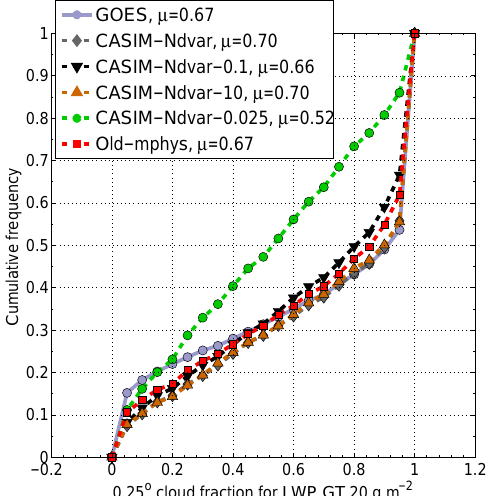
Figure 9. PDFs of LWP for the period from 06:00UTC on 12 November to 00:00UTC on 14 November 2008 from the RV Ronald H. Brown microwave radiometer and various UM model runs. For both the ship and the model, 10min averaged data are used. For the model the 3 × 3 grid boxes centred at the location of the ship (20 ◦ S, 75 ◦ W) are used and combined into one PDF in order to account for the possibility of spatial variability.